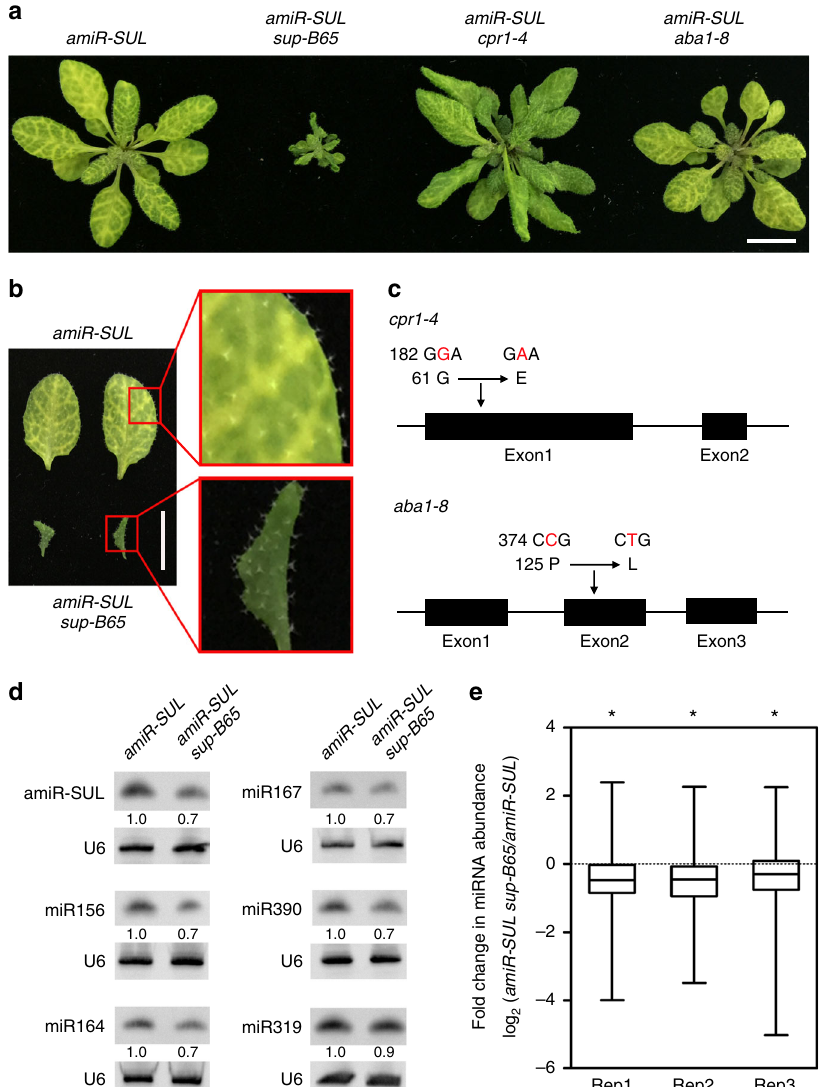
Fig. 1 Isolation and characterization of a mutant with reduced accumulation of miRNAs. a Plants of the following genotypes: amiR-SUL , amiR-SUL sup-B65 , amiR-SUL cpr1 – 4 , and amiR-SUL aba1 – 8 . In addition to reduced leaf bleaching, amiR-SUL sup-B65 plants exhibit pleiotropic phenotypes, including dwar fi sm and twisted leaves. Bar = 1 cm. b Rosette leaves from amiR-SUL and amiR-SUL sup-B65 plants. Portions of the leaves (as marked by the rectangles) were magni fi ed to show the phenotypes of vein-centered bleaching. Bar = 1 cm. c Two candidate mutated sites were identi fi ed in amiR-SUL sup-B65 , one being a transition of G to A, which results in the substitution of Gly182 for Glu, in CPR1 (At4g12560) and the other being a transition of C to T, which leads to the substitution of Pro125 for Leu, in ABA1 (At5g63070). The two alleles were named cpr1 – 4 and aba1 – 8 . d Northern blots to detect six miRNAs (amiR-SUL, miR156, miR164, miR167, miR319, and miR390) in 15-day-old seedlings of amiR-SUL and amiR-SUL sup-B65 . U6 served as an internal control. The numbers indicate the relative abundance of the miRNAs in the two genotypes. e Small RNA sequencing from 15-day-old seedlings of amiR-SUL and amiR-SUL sup-B65 in three biological replicates (Rep1, Rep2 and Rep3). A global reduction in miRNA accumulation was observed in amiR-SUL sup-B65 relative to